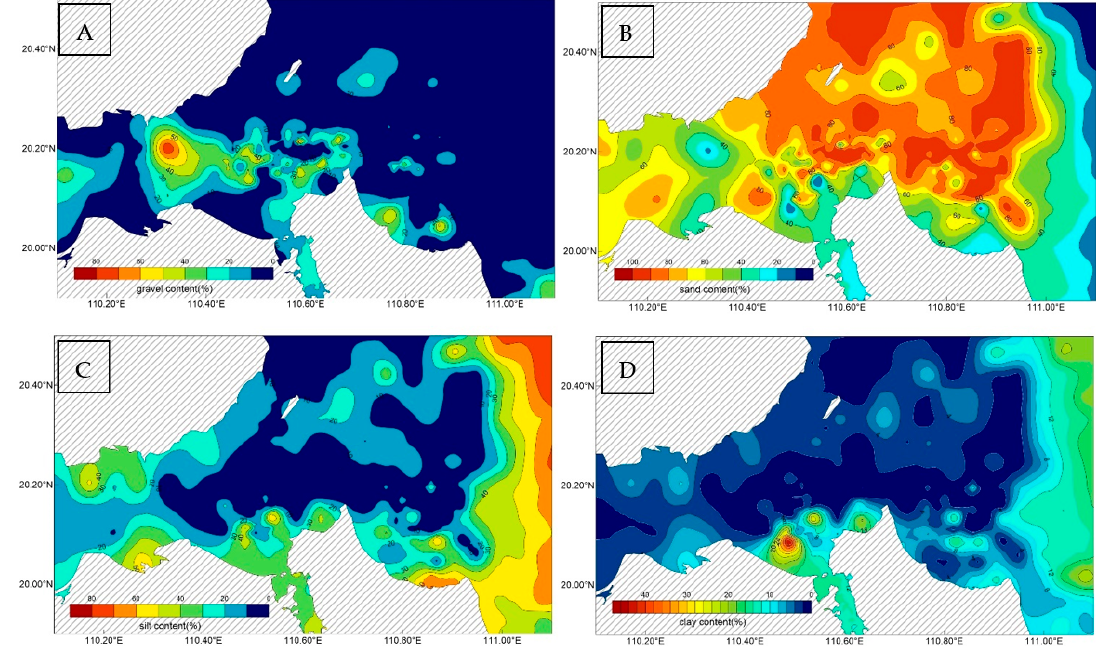
Figure 2. Distribution of sediment components percentage, ( A ) gravel, with contour interval of 10%, ( B ) sand, with contour interval of 10%, ( C ) silt, with contour interval of 10%, and ( D ) clay, with contour interval of 2%.